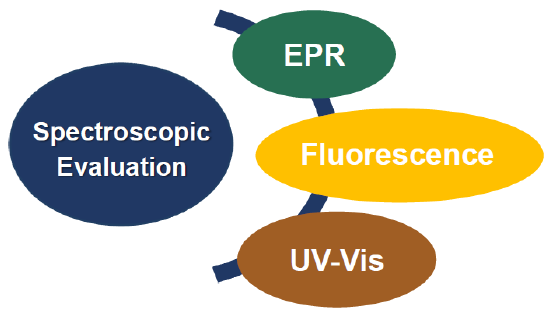
Figure 8. Spectroscopy plays a crucial role in the determination of antioxidant activity. Spectroscopic evaluation can be achieved through ( i ) electron paramagnetic resonance (EPR), ( ii ) ultraviolet-visible (UV–Vis), and ( iii ) fluorescence spectroscopy. EPR spectroscopy enables the direct detection of species that bear at least one single electron. In contrast, different assays can be used to evaluate antioxidant activity through fluorescence and UV–Vis